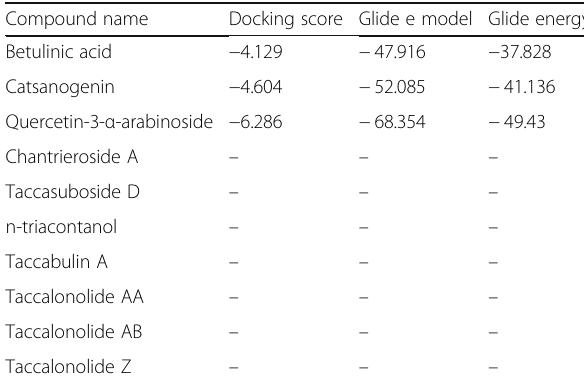
Table 7 Docking result of betulinic acid, catsanogenin and quercetin-3- α -arabinoside with estrogen receptor alpha (ER- α )